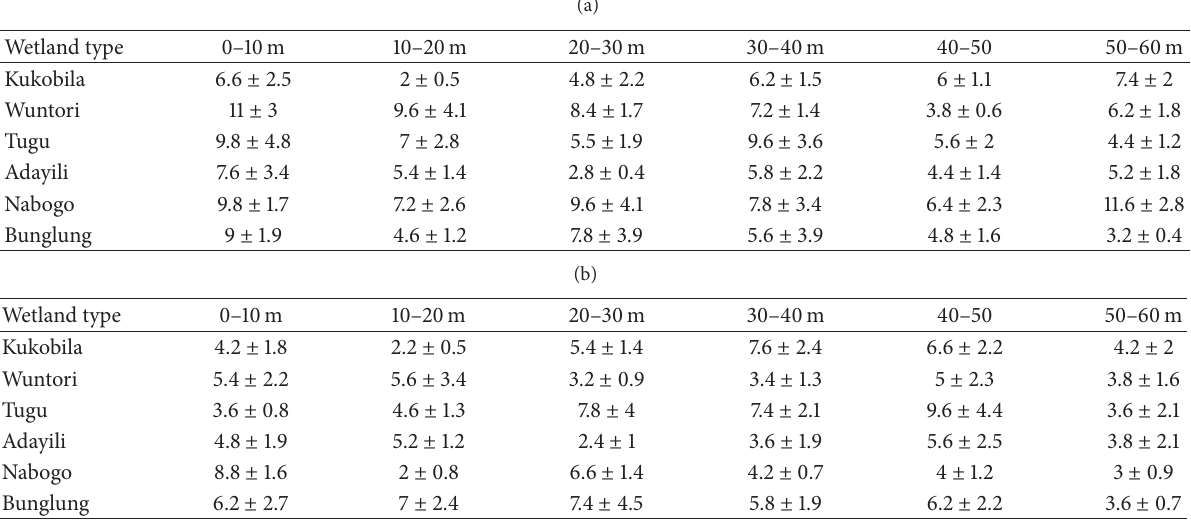
Table 2: (a) Mean number of birds counted in a lateral distance per line transect ( Wet season ). (b) Mean number of birds counted in a lateral distance per line transect ( Dry season